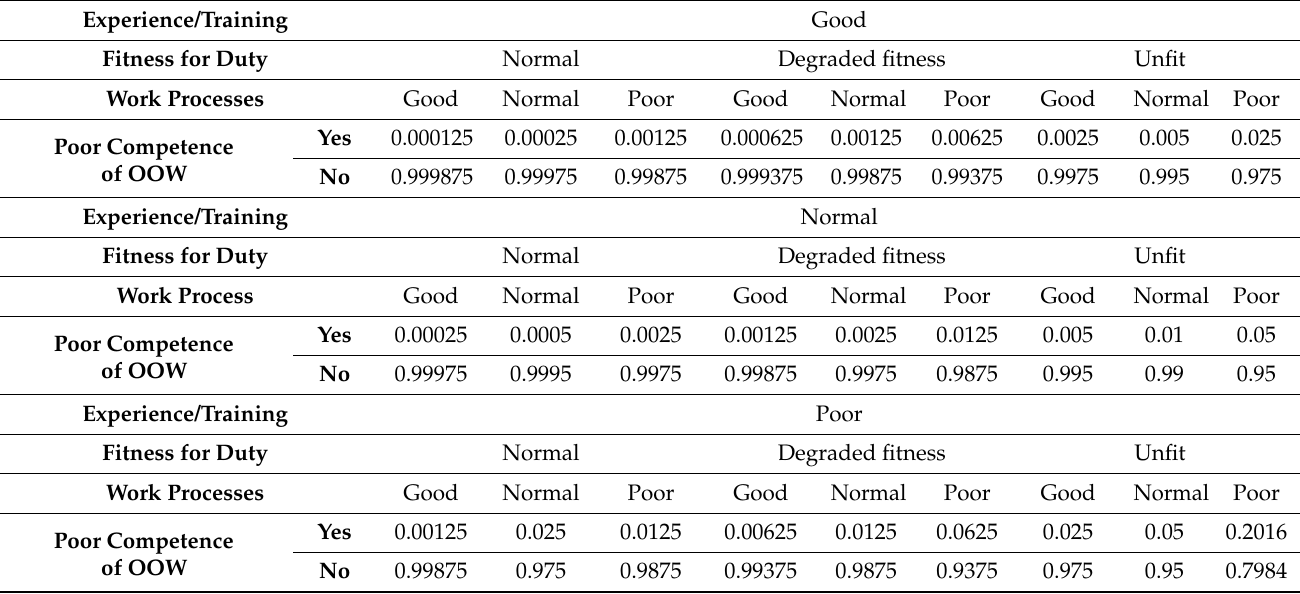
Table 3. CPT of node “Poor competence of OOW”.